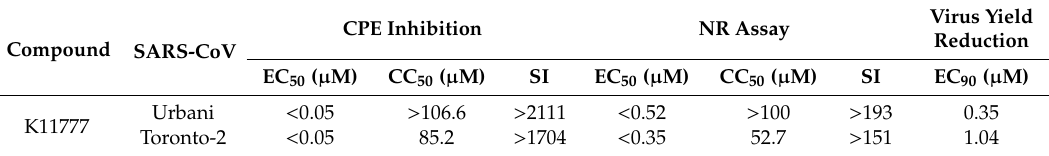
Figure 16. Peptidyl aryl vinylsulfone SAR (left) and the best compound K11777 as irreversible inhibitors of cathepsins and SARS-CoV replication in Vero 76 cells. Table 1. Inhibitory activity of K11777 against SARS-CoV replication in Vero 76 cells.